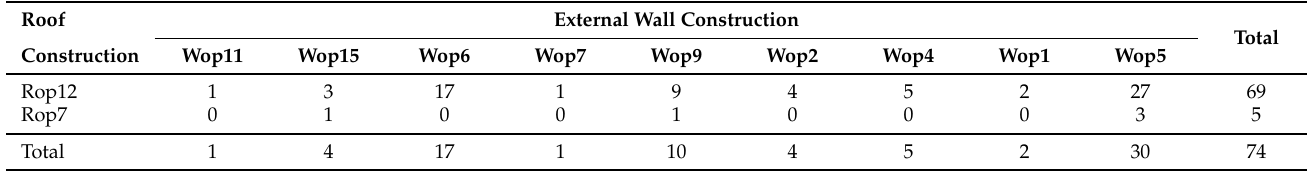
Figure 6. Optimization analysis result at Pareto’s front for the H200 operating in AC mode. Table 7. Resulting counts of each layout combination that appeared at Pareto’s front for the 200 m 2